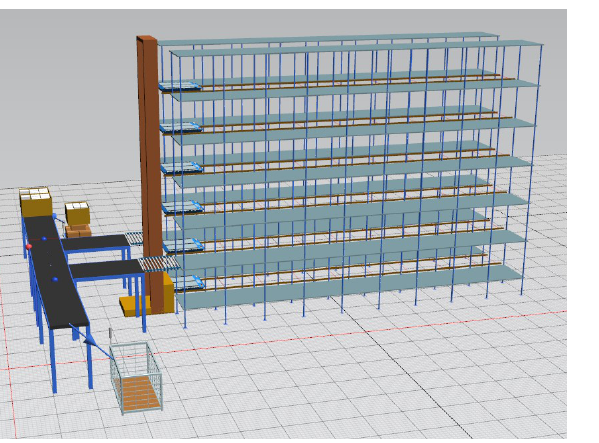
Fig. 3 Model of an SBS/RS.